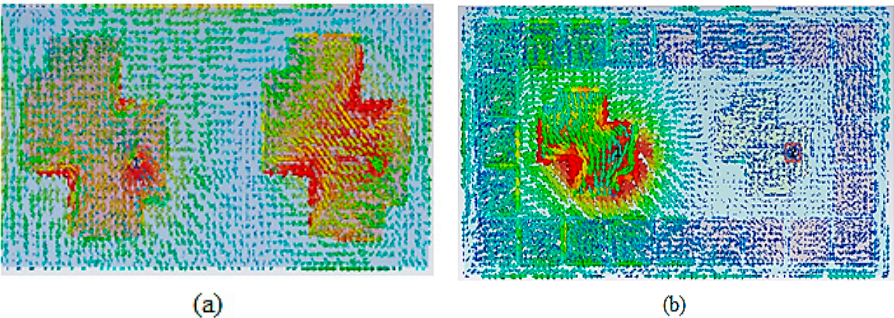
Figure 4. Proposed antenna surface current distribution when Port 1 is excited, and Port 2 is terminated: ( a ) without parasitic elements; ( b ) with parasitic elements.